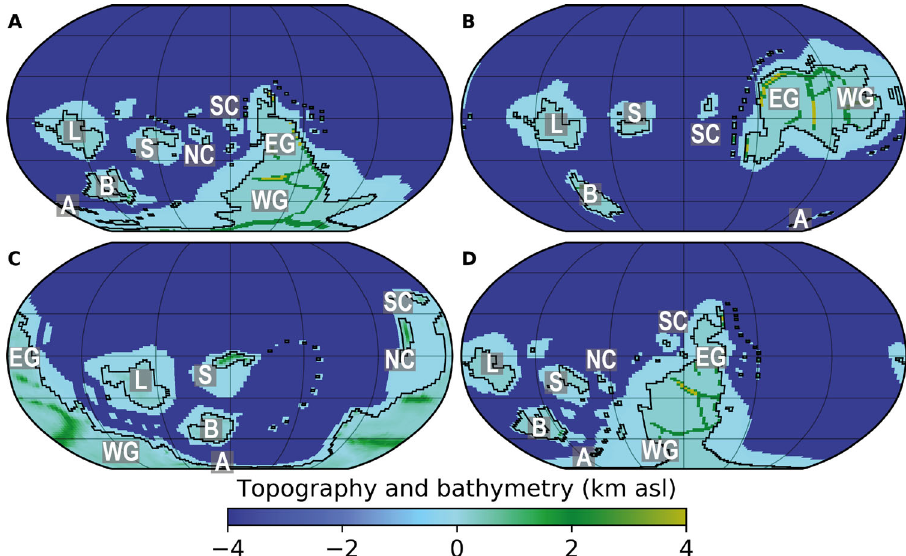
Fig. 1 Four continental con fi gurations (A – D) tested here, overlain with the palaeotopography and palaeobathymetry used in our FOAM simulations. Con fi guration A: 510 Ma reconstruction, after refs. 25 – 27 . Con fi guration B: terminal Ediacaran – early Cambrian reconstruction, after refs. 18,19 . Con fi guration C: 510 Ma reconstruction, after refs. 30,31 . Con fi guration D: Cambrian reconstruction, after ref. 28 . A: Avalonia; B: Baltica; EG: East Gondwana; L: